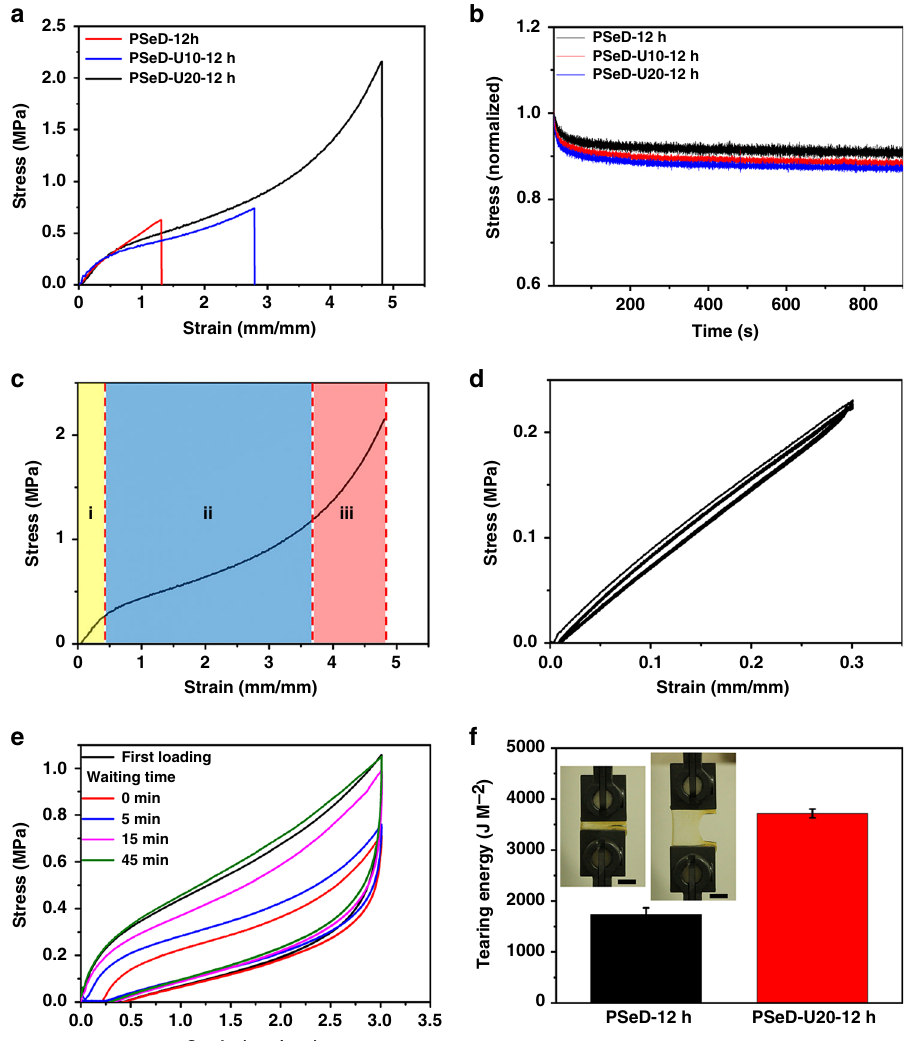
Fig. 2 Skin-like mechanical properties of PSeD-U elastomers. a Typical tensile stress – strain curves of PSeD-U-12h elastomers with different densities of hydrogen bond while practically identical covalent crosslinking densities. b The stress relaxation curves of samples stretched at 5% strain for 900 s. c Dependence of stress on the strain, the stress – strain curve can be divided into three regions depending on the ranges of strain. d Cyclic tensile tests with a strain of 30%. e The tensile stress – strain curves of loading-unloading cycles with 300% strain with different waiting time between two consecutive loadings. f The comparison of tear energy of PSeD-12h and PSeD-U20-12h. The insert photograph is a notched PSeD-U20-12h specimen with a strain of 300%, showing its high tear resistance. Scale bar = 10